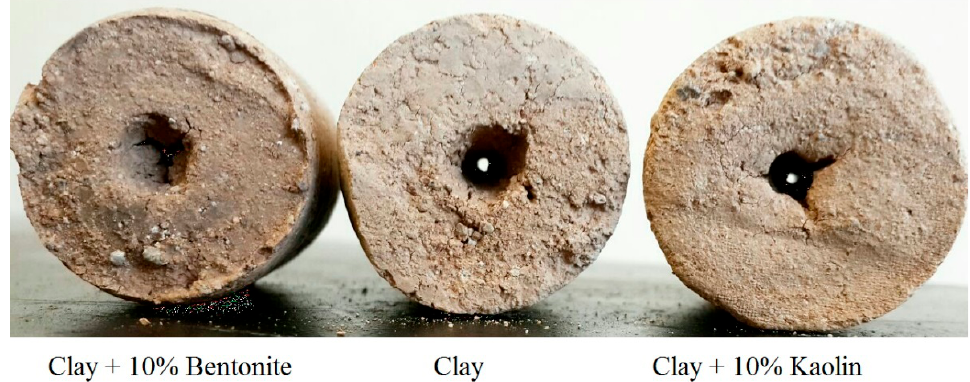
Figure 12. Repairing of the sample holes in the pinhole test.